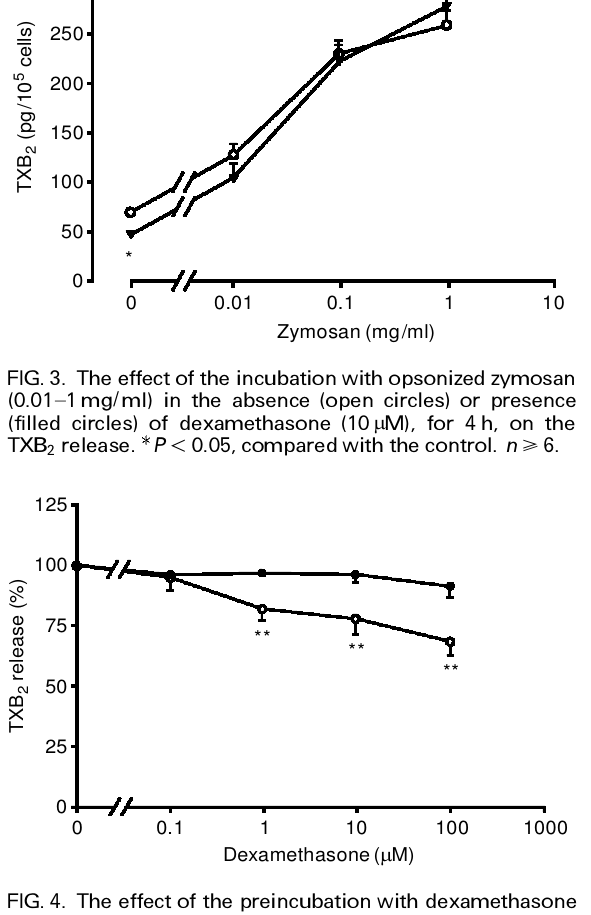
FIG. 4. The effect of the preincubation with dexamethasone (0.1 ± 100 m M), for 4 h (® lled circles) or 24 h (open circles), on the TXB 2 release induced by the further incubation, for 1 h, with opsonized zymosan (1 mg / ml). P , 0.01, compared with the control (100% = release induced by 1 mg / ml of opsonized zymosan). n > 6.